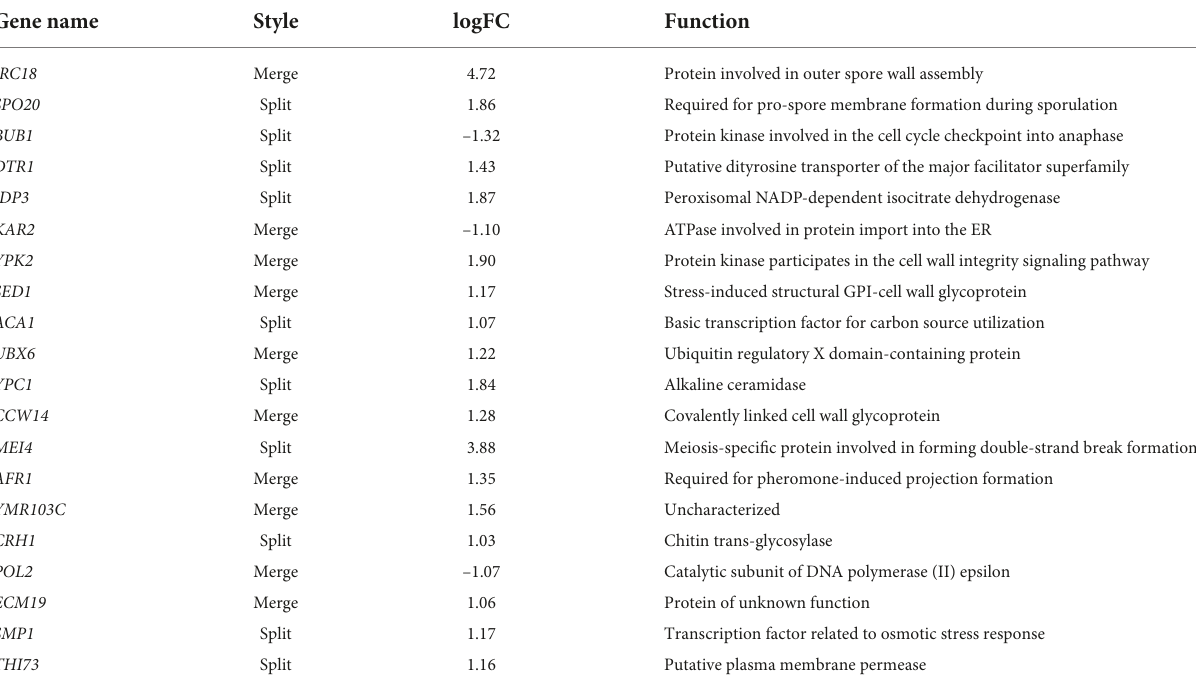
TABLE 2 The relationship between TAD boundaries shifting and transcription in comparison of EMV-8 and